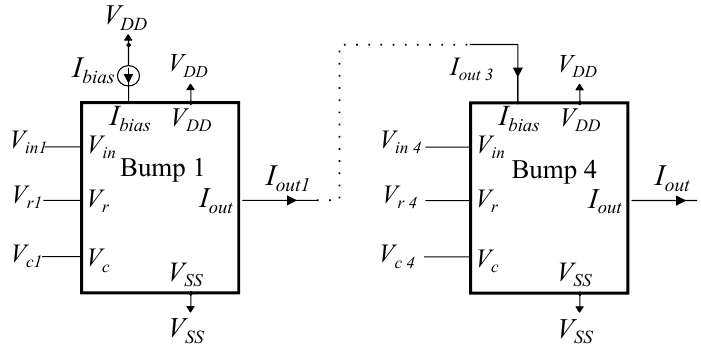
Figure 4. A 4D Bump circuit implementation composed of four sequentially connected univariate bump circuits.